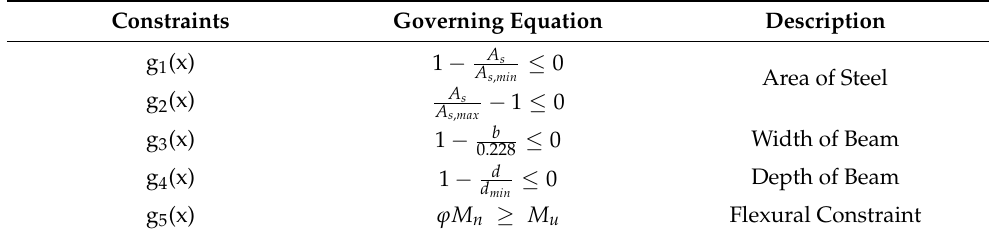
Table 1. A summary of the constraints used in the